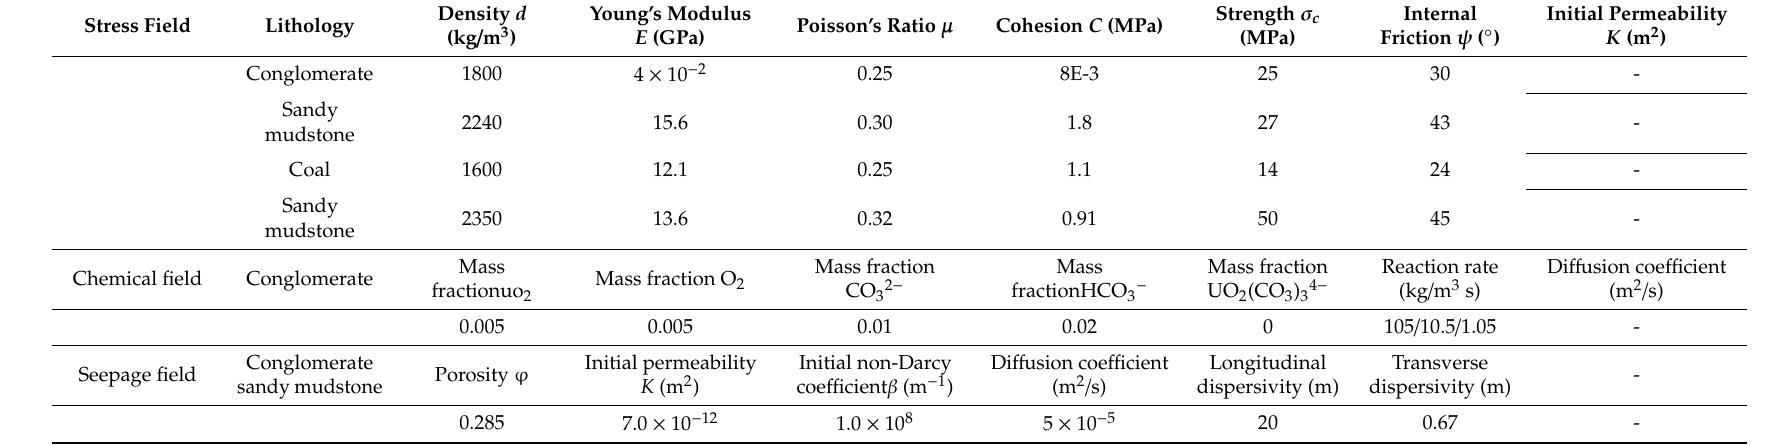
Table 1. Mechanic and hydraulic parameters for the numerical